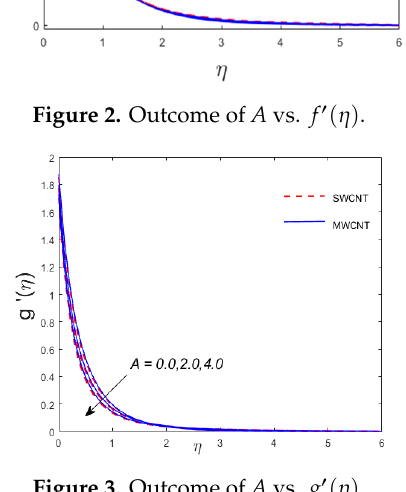
Figure 3. Outcome of 𝐴 vs. 𝑔′(𝜂) .